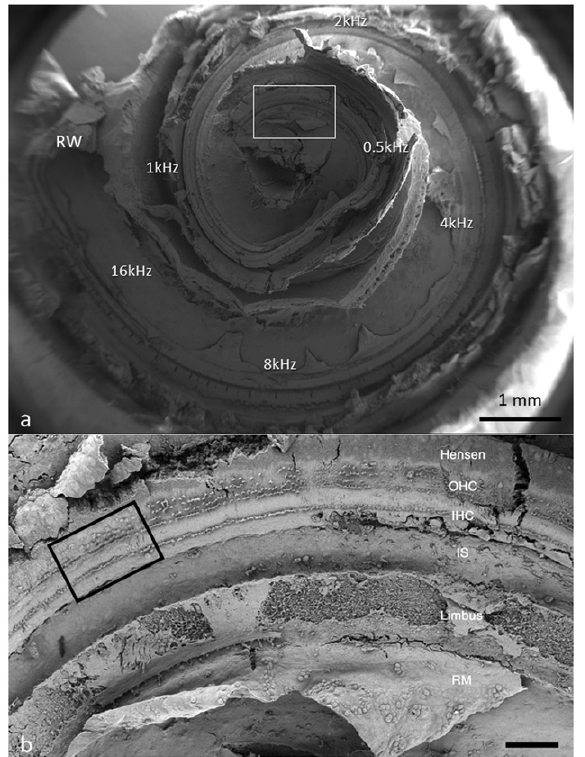
Figure 3. Image a: Field emission scanning electron microscopy (FESEM) of the cochlea of patient 1 ( $ 48 y.o.) with a normal audiogram (PTA). The framed area is magnified in image b. The most apical part was traumatized during preparation and is not shown. The IHCs were plotted and are shown in Figure 5. According to the Greenwood place/frequency scale, 2,321 IHCs were repre- sented in the 0.2kHz – 4kHz region (20,175 l m), corresponding to one hair cell per 8.7 l m or 11 – 12 IHCs per 100 l m of length. Image b: Higher magnification of the framed area shown in Image a. The exposed region corresponds to the junction between the upper second and lower apical turns of the cochlea.